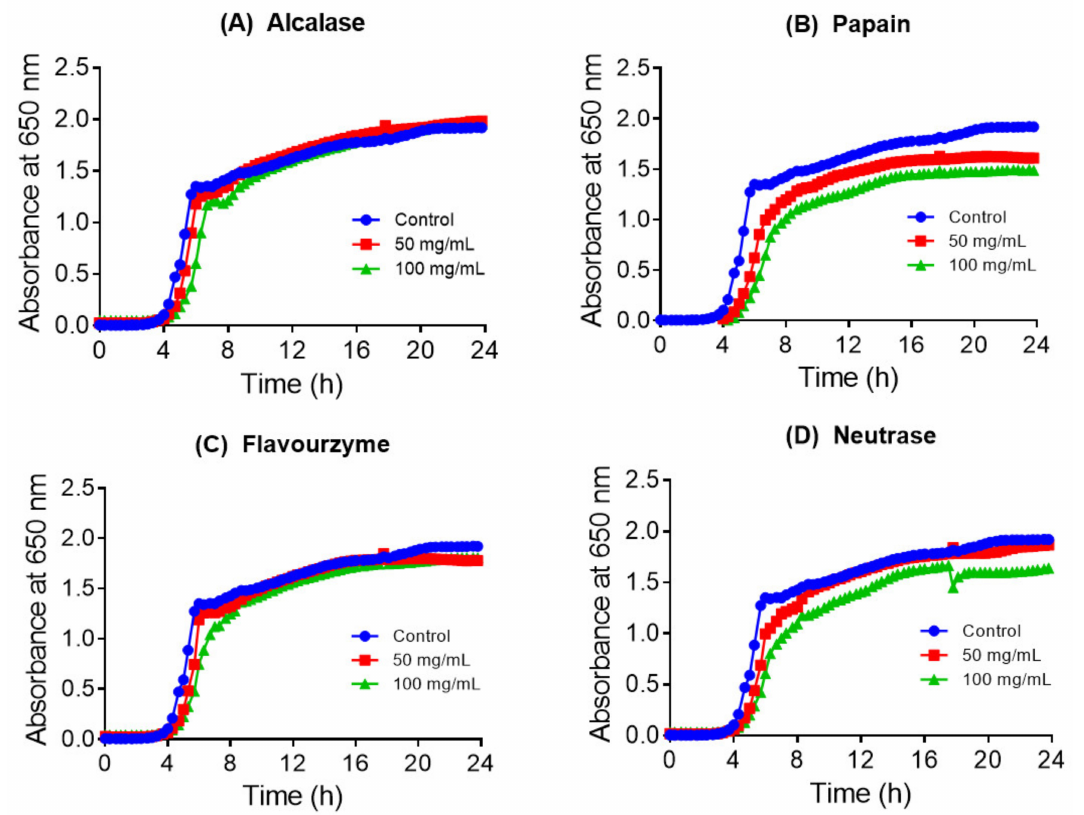
Figure 3. Growth curves of S. abony in the absence (control) and presence of collagen hydrolysates produced with four enzymes ( A ) Alcalase, ( B ) papain, ( C ) Flavourzyme, and ( D ) Neutrase. Experiments were conducted three times, and each data point represents the mean